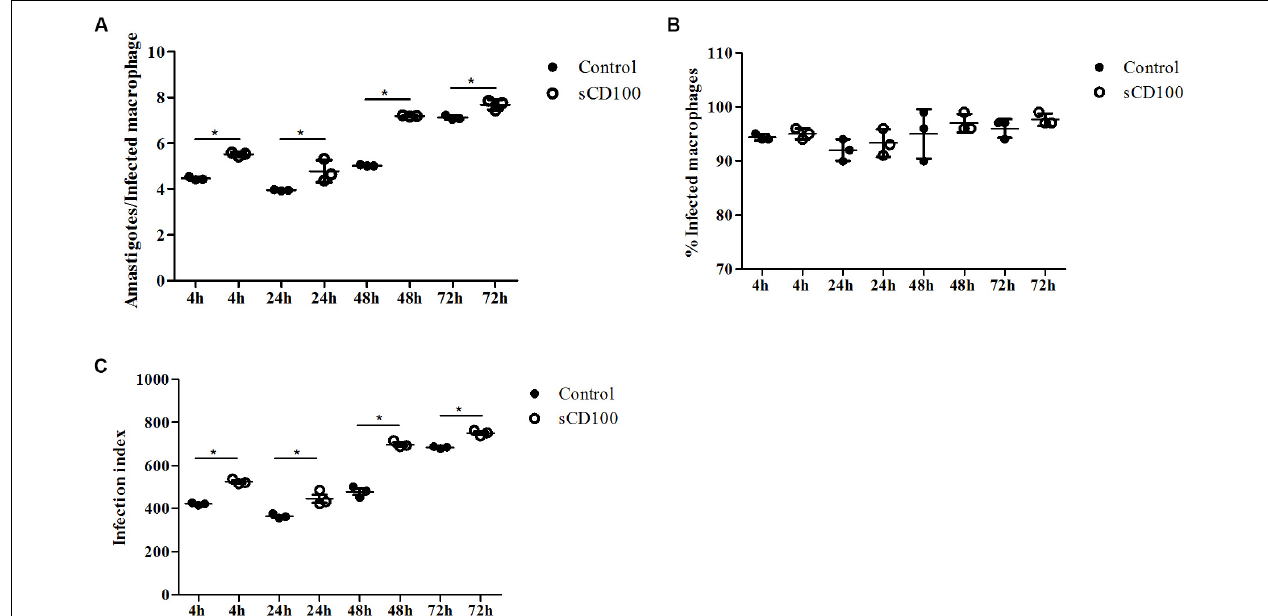
FIGURE 2 | Effects of sCD100 on infection of macrophages. Macrophages from BALB/c mice were infected with L. (L.) amazonensis promastigotes at a MOI of 5 per 4, 24, 48, or 72 h in the presence or not of 100 ng/mL sCD100. (A) Amastigotes per infected cell. (B) Percentage of infected macrophages. (C) Infection index. Statistical analysis was performed by ANOVA with Tukey’s post-test, and significant differences are labeled as ∗ p ≤ 0.05. Results of a representative experiment of three with similar profiles.